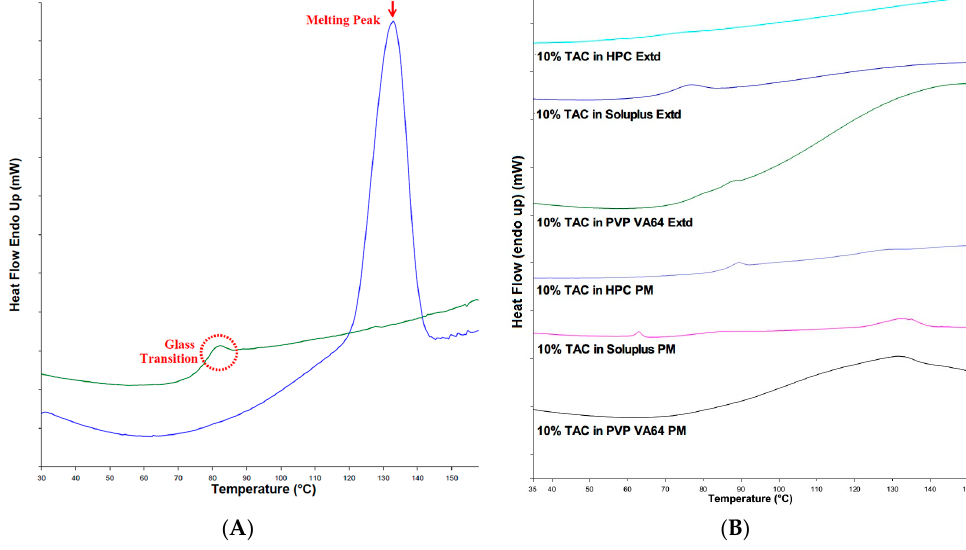
Figure 4. ( A ) DSC thermograms of TAC, first heating cycle showing melting peak and second heating cycle showing glass transition; ( B ) DSC of physical mixtures and formulations containing TAC.